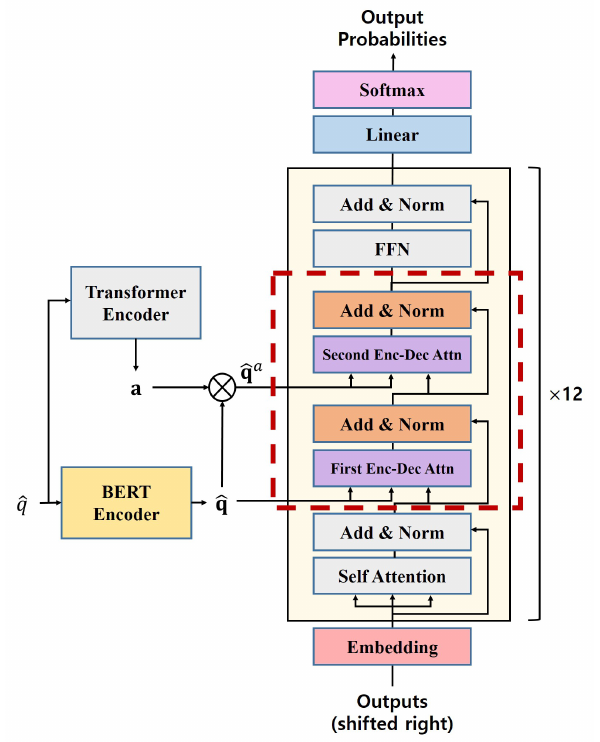
Figure 2. The structure of the proposed response generator,